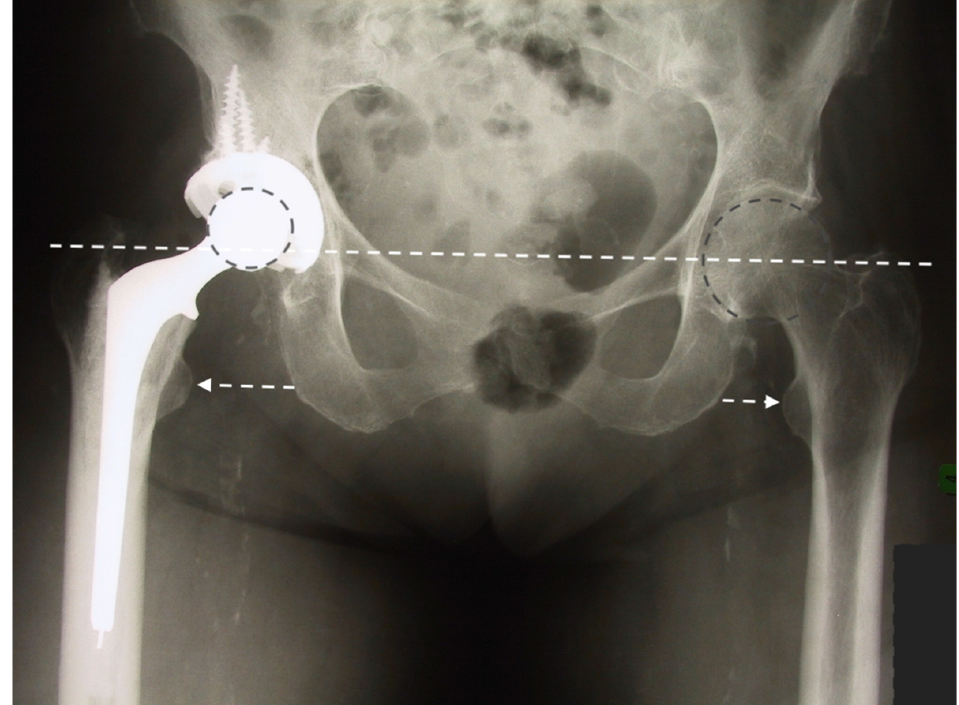
Figure 4. Anteroposterior pelvis radiograph of a patient complaining of right hip pain. Compared to his native left hip, the right 28 mm THA center of rotation was elevated, the femoral offset was increased, and leg length was shortened.